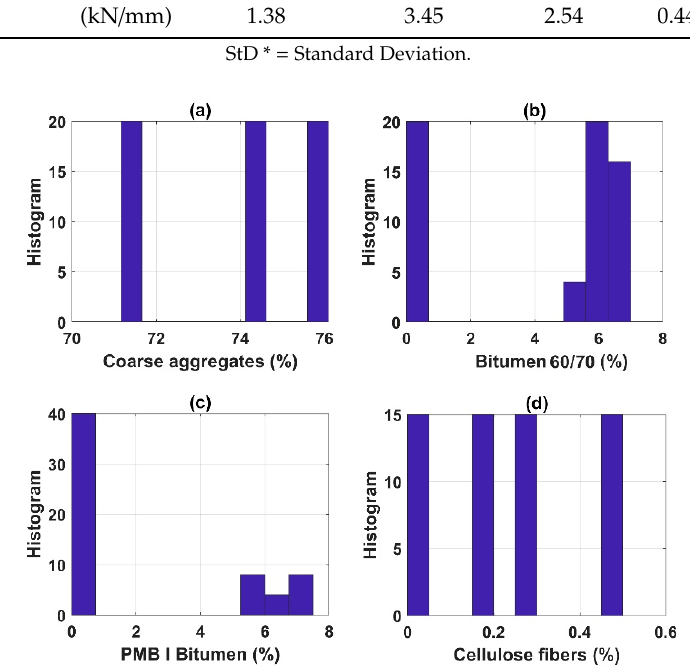
Figure 3. Histogram of the input parameters in this study for: ( a ) coarse aggregates; ( b ) Bitumen 60/70; ( c ) PMB I Bitumen and ( d ) cellulose fibers.